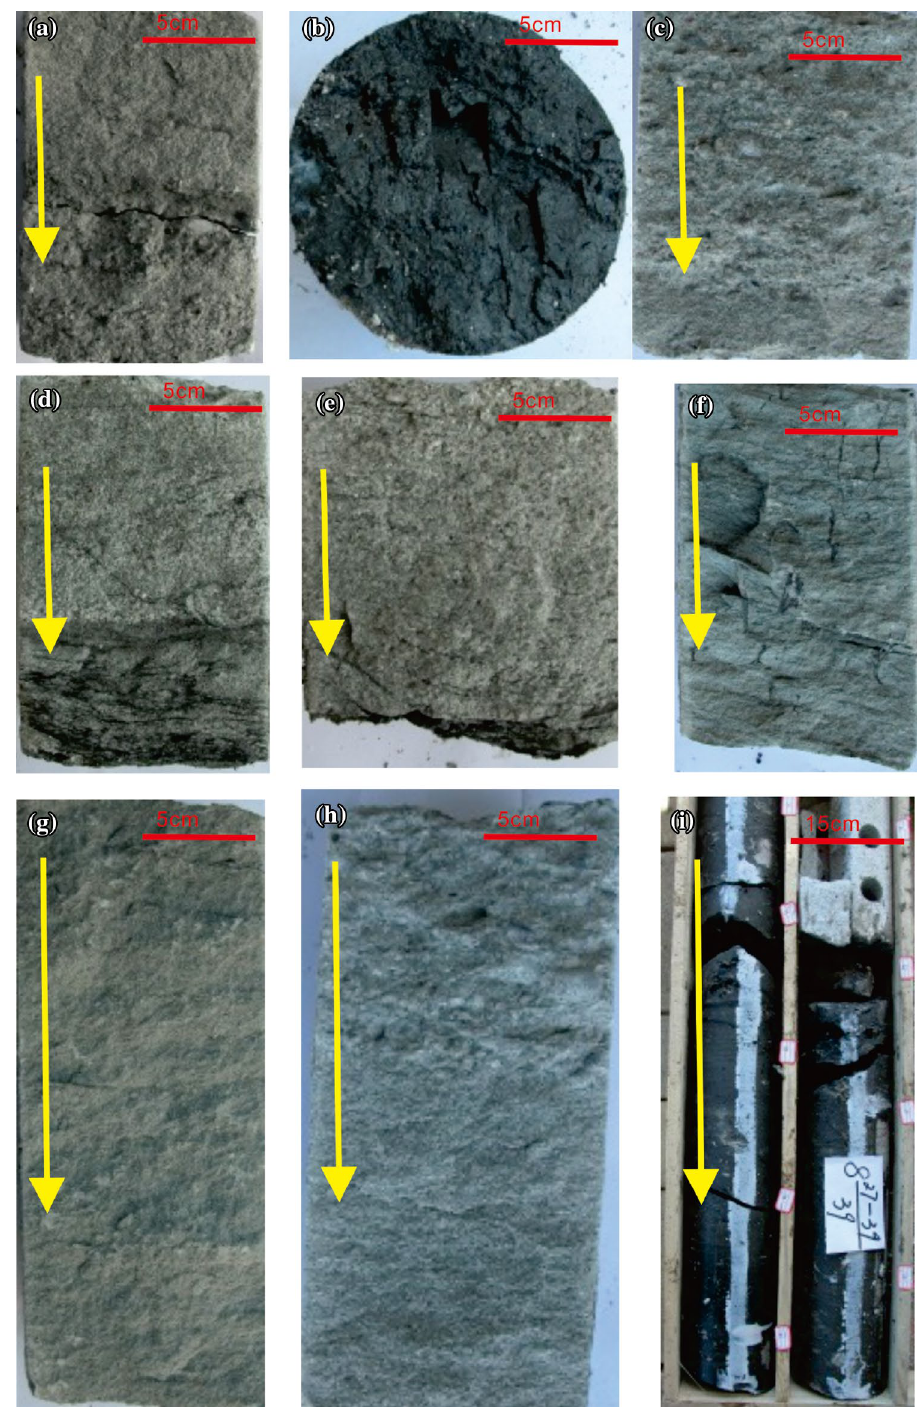
Fig. 3 Typical sedimentary structures of shallow-water braided delta in Baobei District, Baolang oilfield. a Light grey conglomeratic medium sandstone with massive bedding b black carbonaceous shale c light grey medium conglomer- ate with graded bedding d light grey gravelly sandstone with parallel bedding e light grey sandy conglomerate with plate cross-bedding f light grey fine sandstone with cross-bedding g light grey fine sandstone with parallel bedding h light grey medium conglomerate with graded bedding i dark grey mudstone with coal